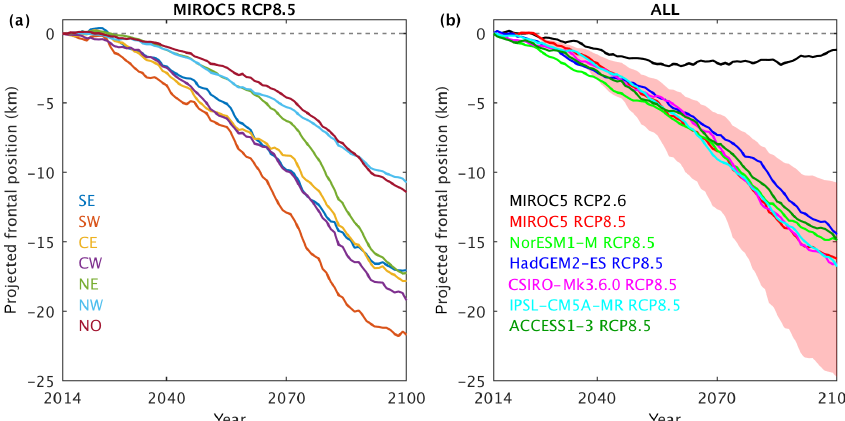
Figure 9. Projected tidewater glacier frontal position for forcing of Greenland ice sheet models. (a) Sector-by-sector retreat from the MIROC5 RCP8.5 simulation, showing only the medium retreat. (b) Retreat in all CMIP AOGCMs considered, where the sectors in (a) are combined according to their present-day relative ice flux (Table S1). Also shown in the shading are the low and high retreat projections for MIROC5 RCP8.5. Note that the ice sheet models are forced on a sector-by-sector basis, so the projections in (b) are not used to force any models but are included to give a sense of the multi-model variability. See Fig. S8 for full plots of all projections.